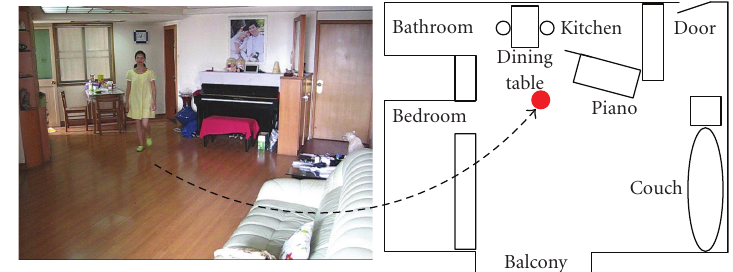
Figure 4: Example image of corresponding 2D/3D mapping in home-care